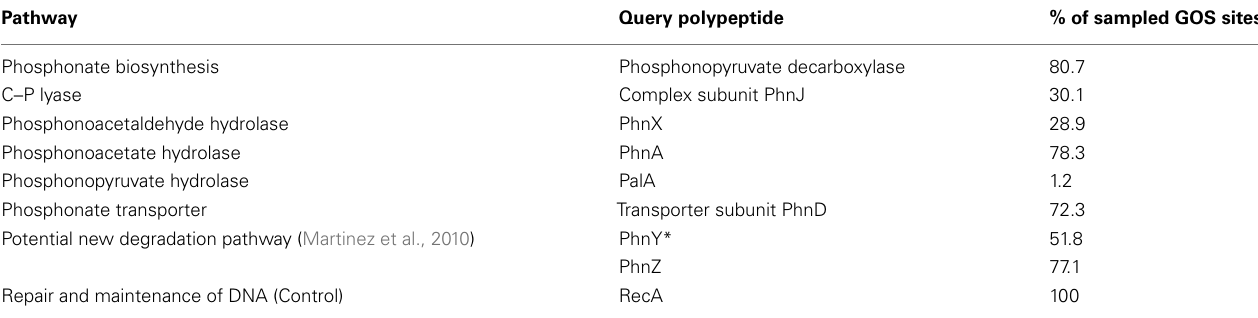
Table 3 | Presence of genes encoding pathways of phosphonate metabolism at the 83 oceanic sites sampled by the GOS Expedition. Pathway